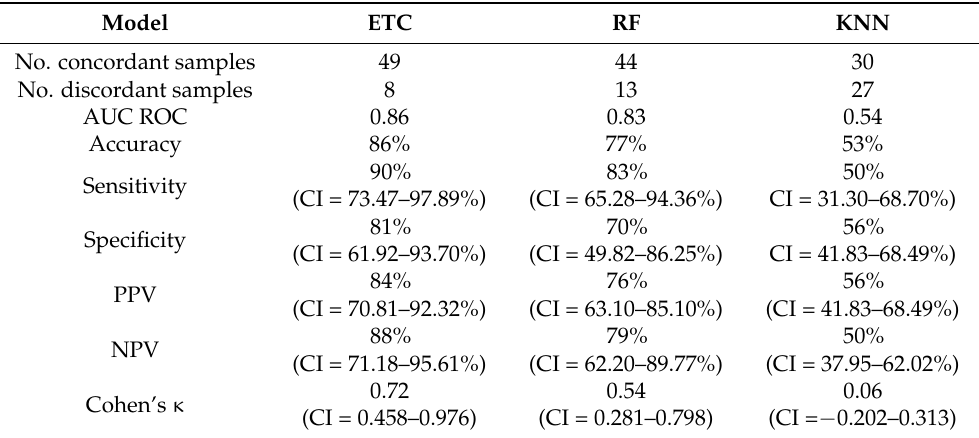
Table 3. Precision assessment of the ML generated circRNA signature with ETC, RF and KNN. The 95% CI are indicated.